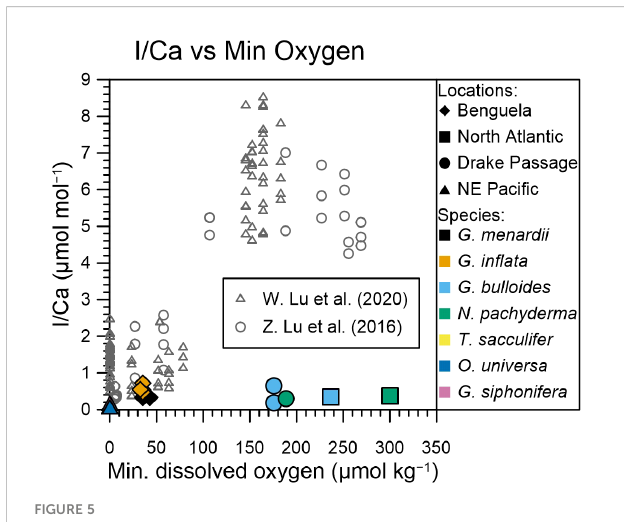
FIGURE 5 Same as Figure 3, but with added planktic foraminifera core-top samples (grey) from Lu et al. (2016b) and Lu et al. (2020). The colors and symbols of plankton-tow samples are as in Figure 3. Note the change in scale for the x-axis needed to include the core-top